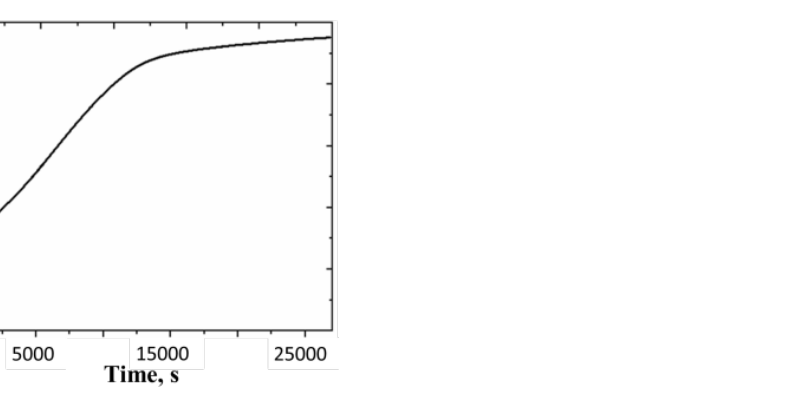
Figure 2. Rising open circuit potential of polyaniline film with initial potential of − 0.2V. Concentration of H 2 SO 4 = 0.5 M, surface mass density of the film = 24.4 g m −2 , temperature = 25 °C. All potentials are reported with respect to SCE.